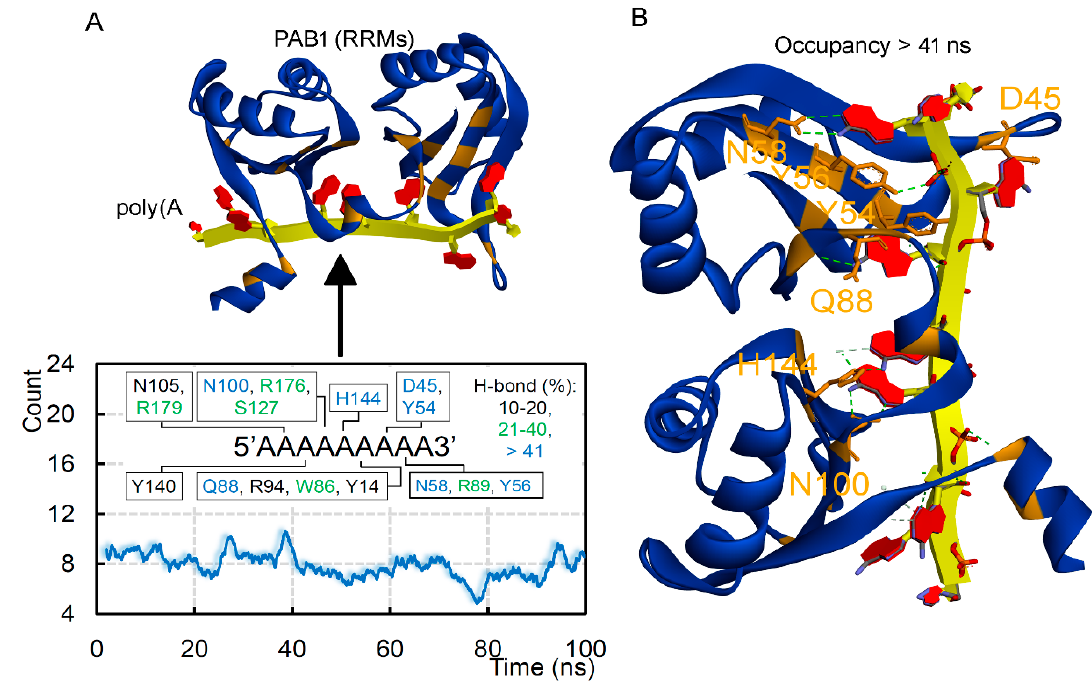
Figure 4. The binding patterns of PABPC1 with the poly(A) mRNA. ( A ) Intermolecular hydrogen bond interactions between PAB1-poly(A) mRNA, as well as individual amino acids interacting with nucleotides having an occupancy of ≥ 10% or nanoseconds (ns), are highlighted. ( B ) Position of high-occupancy (>41%) residues and their binding pattern with the poly(A) mRNA, represented over the PABPC1 structure.